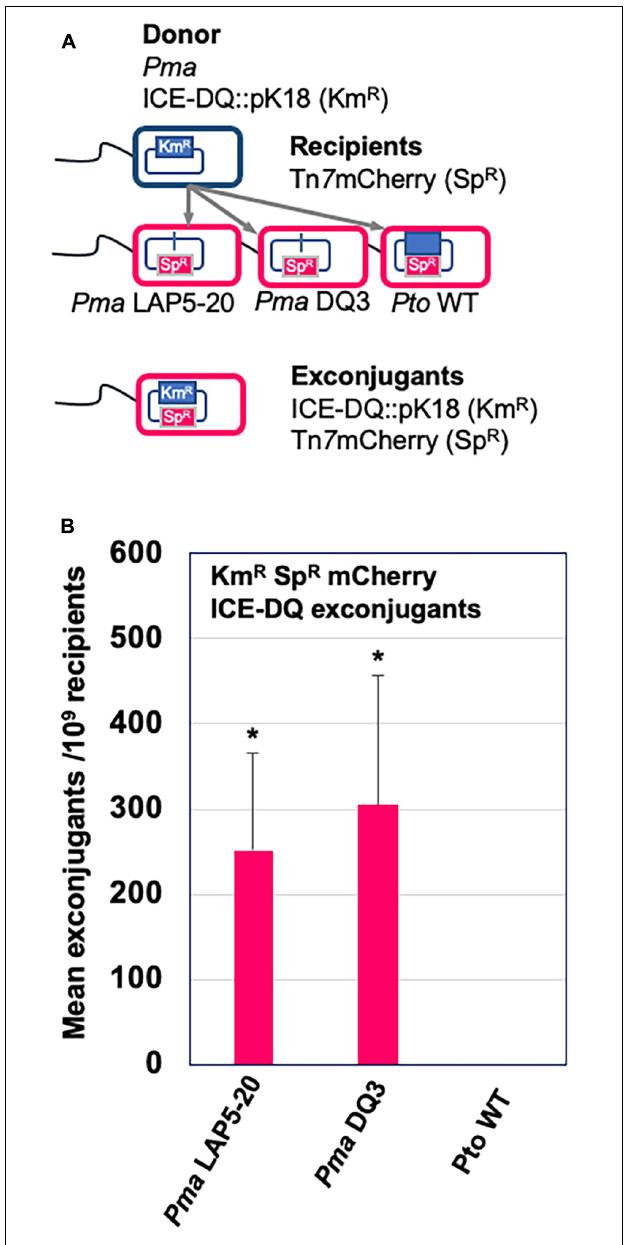
FIGURE 6 | ICE-DQ can be readily transferred into Pma ES4326 strains that lack the ICE element. (A) Schematic representation of the conjugation strategy for monitoring ICE-DQ transfer between strains. The ICE-DQ of the donor strain was marked with kanamycin resistance by single crossover integration the pK18ms plasmid ( Pma ICE-DQ:pK18). The recipient strains Pma DQ3 ( (cid:49) ICE-DQ targeted), Pma LAP5-20 ( (cid:49) ICE-DQ passage-derived) and Pto DC3000 were marked by introduction of a spectinomycin resistance Tn 7 3xmCherry transposon. Donor and recipients were co-cultured on LM media and ICE-DQ:pK18 mCherry expressing ICE-DQ exconjugants were recovered on kanamycin and spectinomycin. (B) ICE-DQ:pK18 exconjugant recovery frequencies/10 9 recipients were determined based on kanamycin and spectinomycin exconjugants per spectinomycin resistant recipients as determined by dilution plating. Values are means and standard deviations of three biological replicates. * p < 0.05 compared to Pto WT strain as determined by unpaired one-tailed t